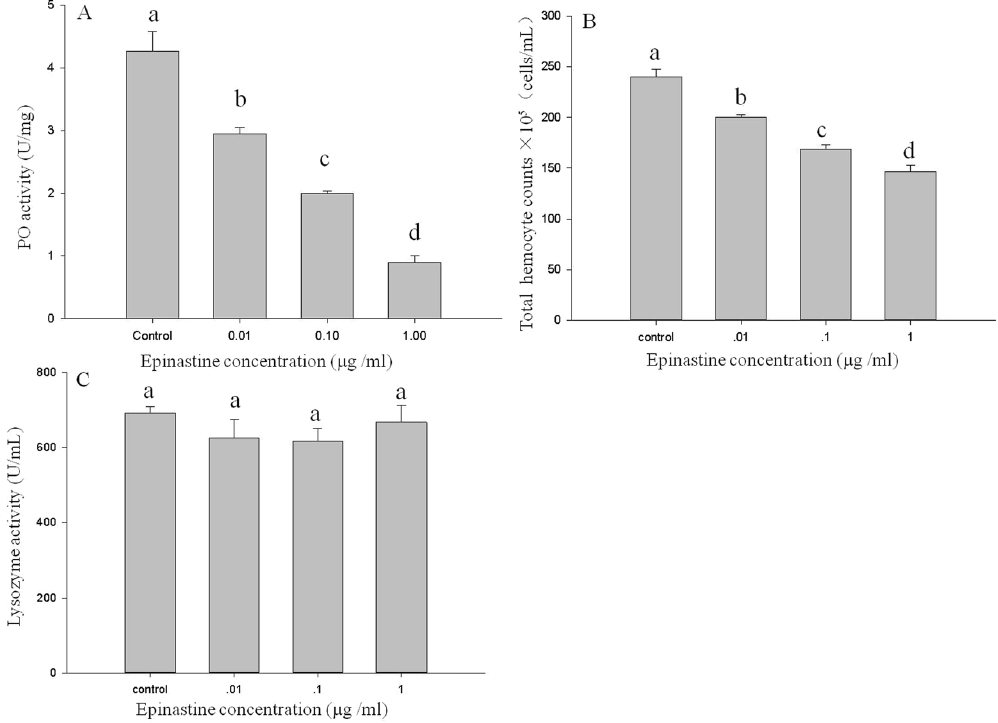
Figure 4. The three measures of immune function in M . separata larvae injected with different concentrations (0.01, 0.1, 1 µ g/mL) of the octopamine antagonist epinastine. ( A ) Phenoloxidase activity. ( B ) Total haemocyte count. ( C ) Lysozyme activity. Values are means ± SE. Different letters indicate significant differences at P <